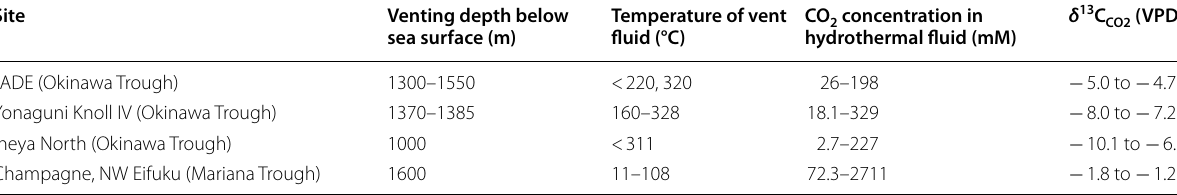
pool beneath the seafloor 2